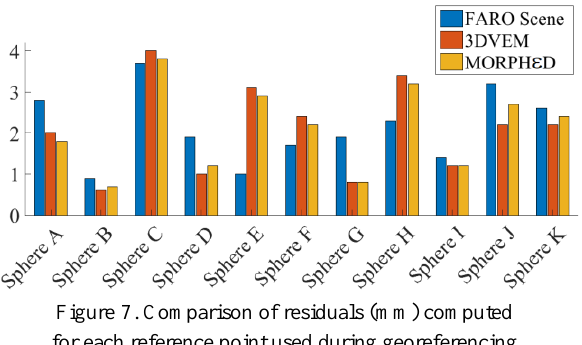
Figure 7. Comparison of residuals (mm) computed